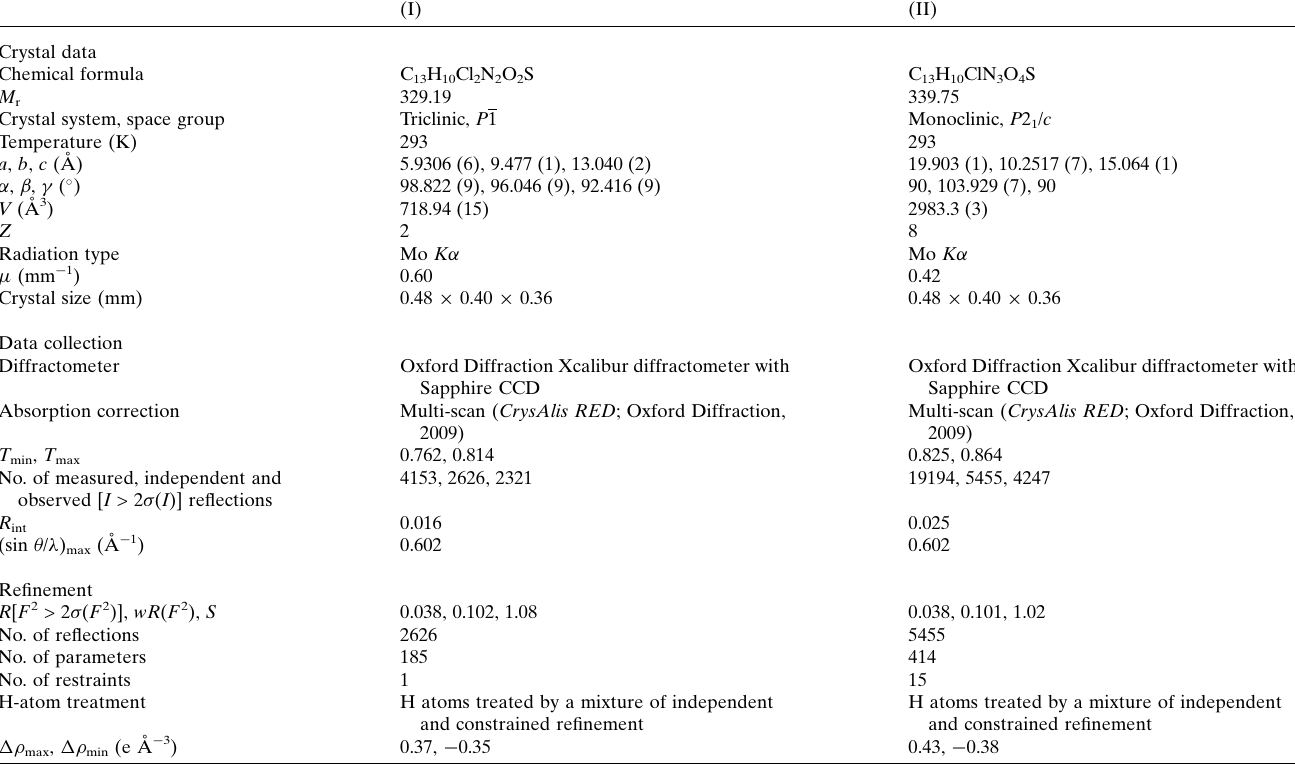
Table 4 Experimental details.